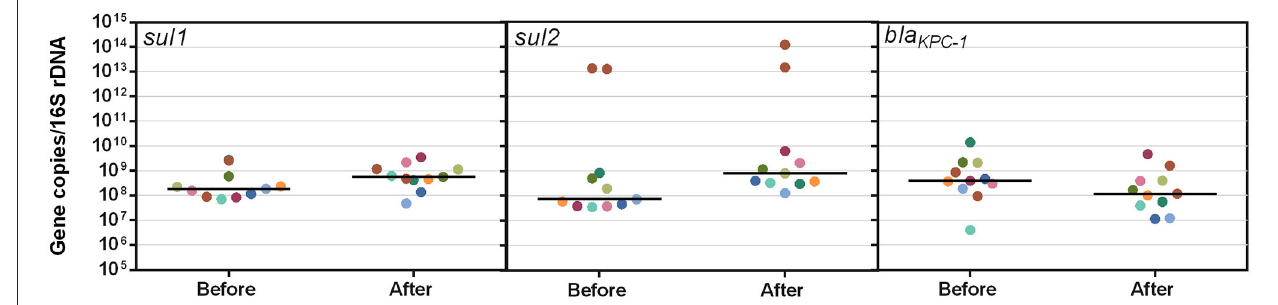
FIGURE 8 | Copy number of antibiotic resistance genes/16S rDNA copies in colonies isolated on antibiotic free media before and after sub-MIC exposure to SMX ( sul1 and sul2 ) and AMX ( blaKPC-1 ). The line for each data set represents the median.